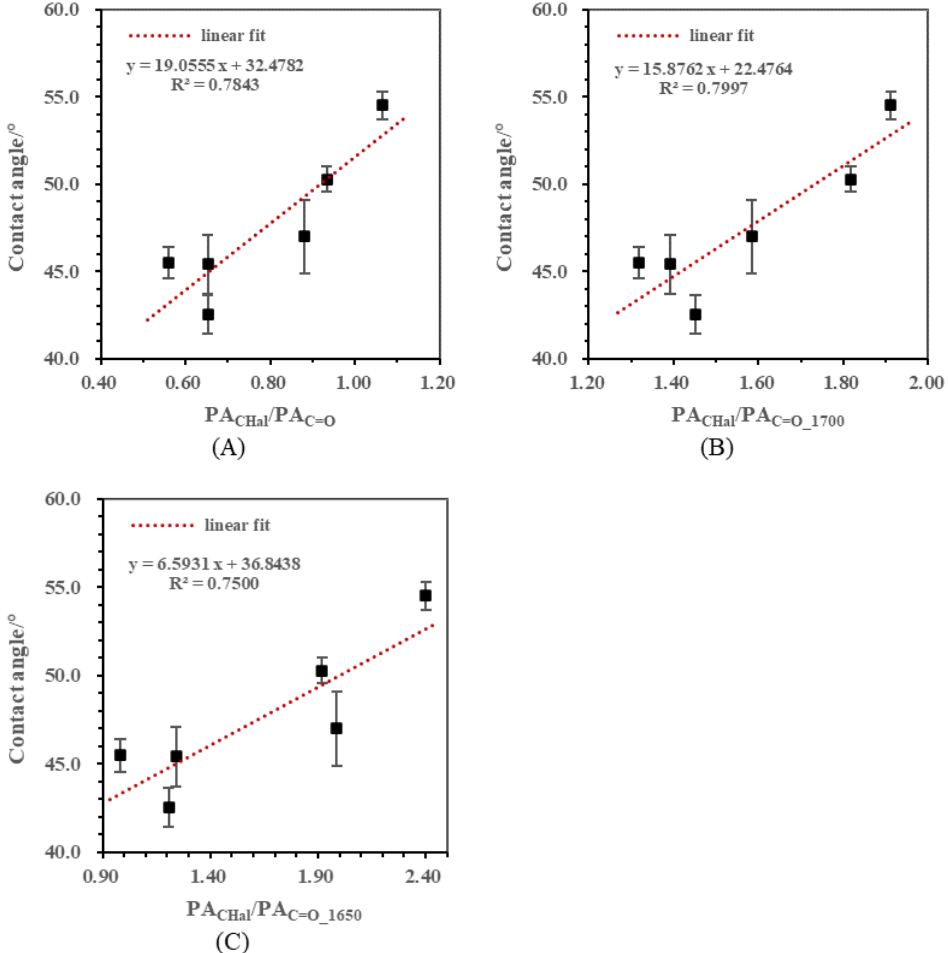
Figure 4. Correlations between contact angles and aliphatic semi-quantitative ratios. ( A ) Correlation between contact angle and PA CHal /PA C=O ; ( B ) Correlation between contact angle and PA CHal /PA C=O_1700 ; ( C ) Correlation between contact angle and PA CHal /PA C=O_1650 .